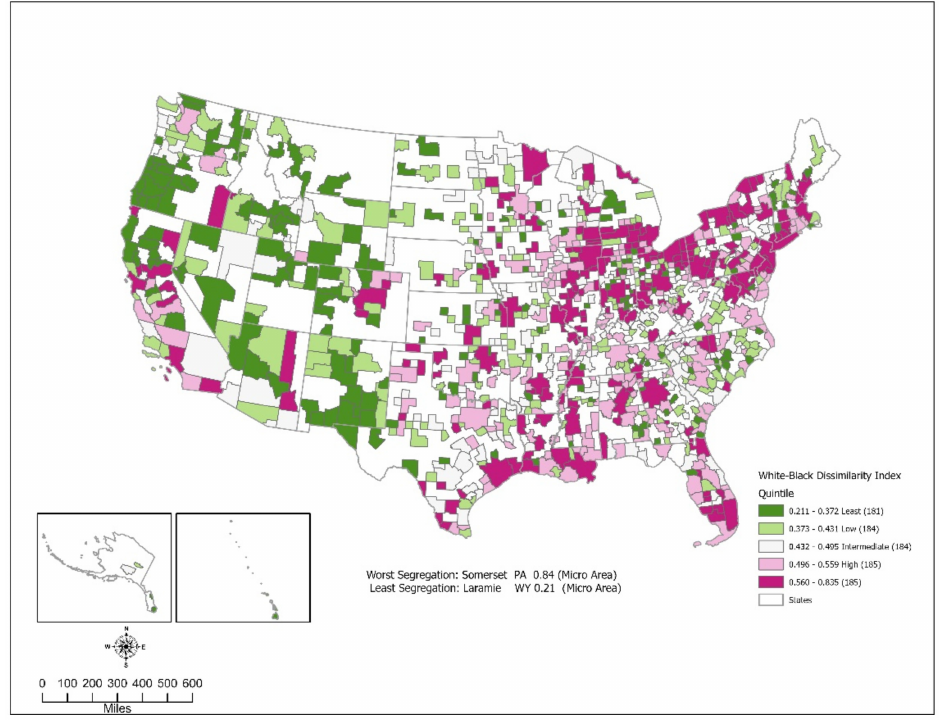
Figure 13. White-black Segregation Indices, Metro/Micro Areas